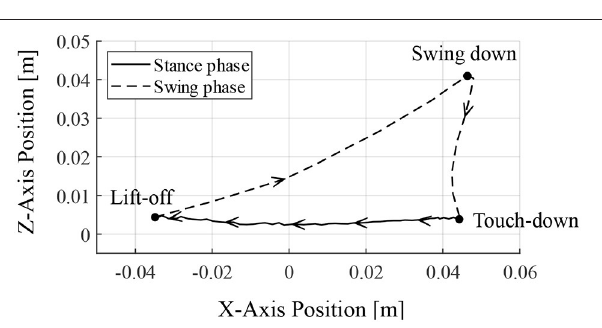
FIGURE 9 | Toe trajectory of the right–hind leg. The foot position is based on the hip joint in the x-axis and the ground in the z-axis. Only one cycle of walking is shown from the time of ground contact at 6.95